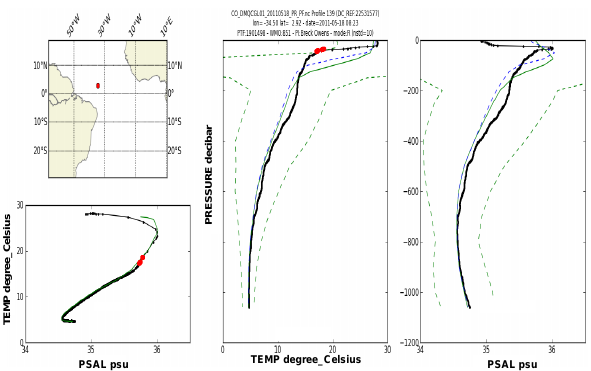
Fig. 7. A profile that fails the climatology test using an envelope at 10 σ but that was requalified as good after a visual check. Red dots indicate observations extracted by the test.